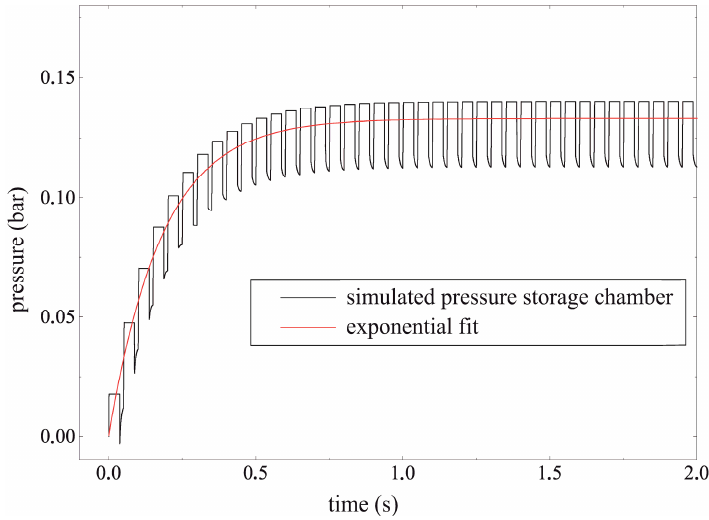
Figure 18. Simulated time dependent pressure under the storage chamber